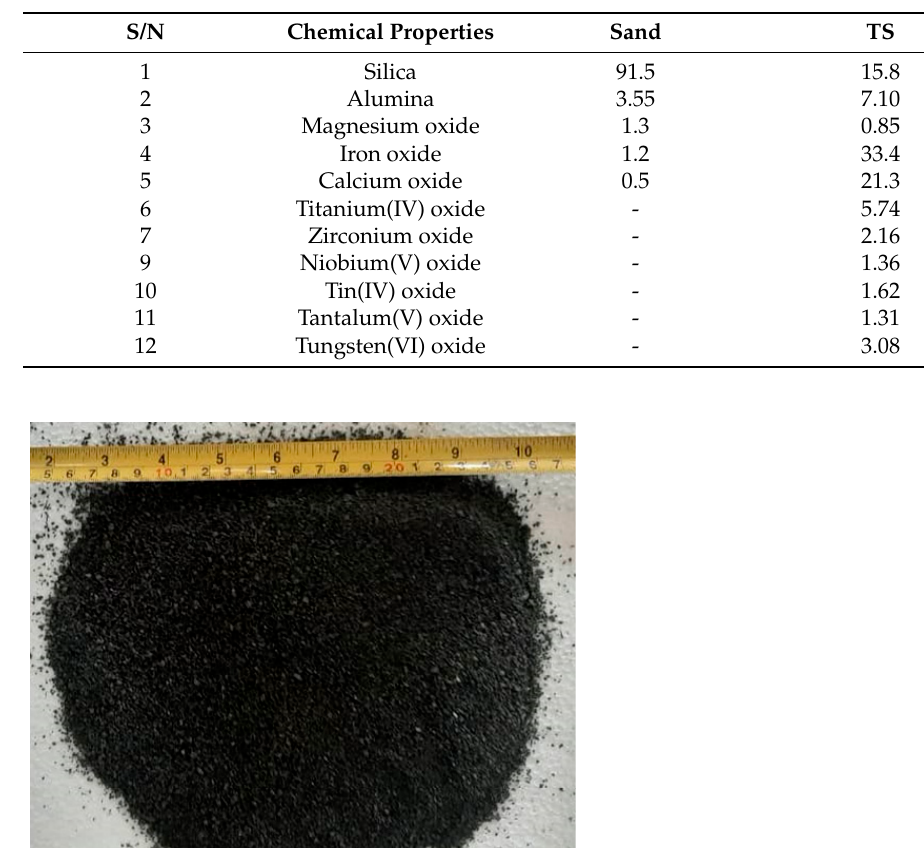
Table 2. Chemical properties showing major oxides of fine aggregate and tin slag.